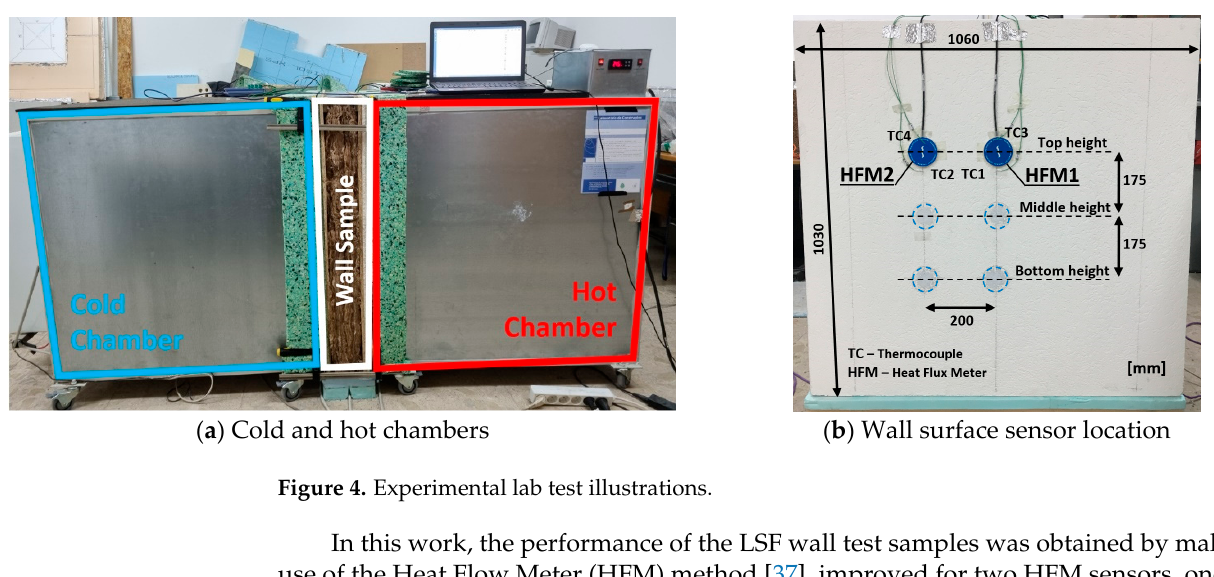
Figure 3. Positionings of the Thermal Break Strips (TBSs).